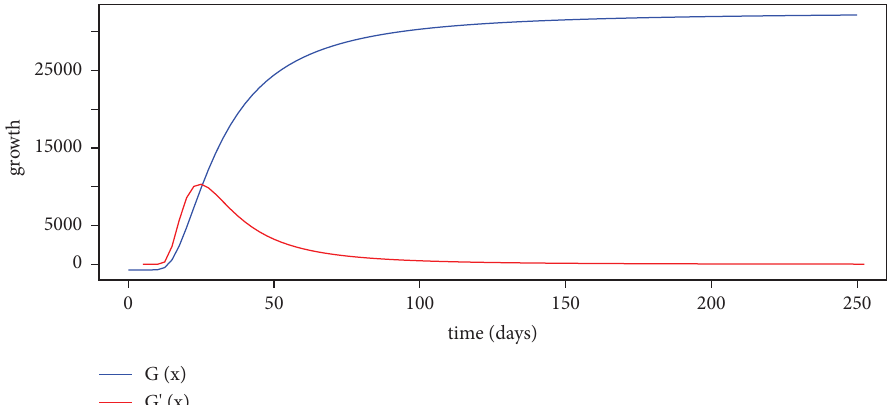
Figure 6: Gompertz curve with fnal level of 300,000. Te red line shows the corresponding change curve multiplied by 10.